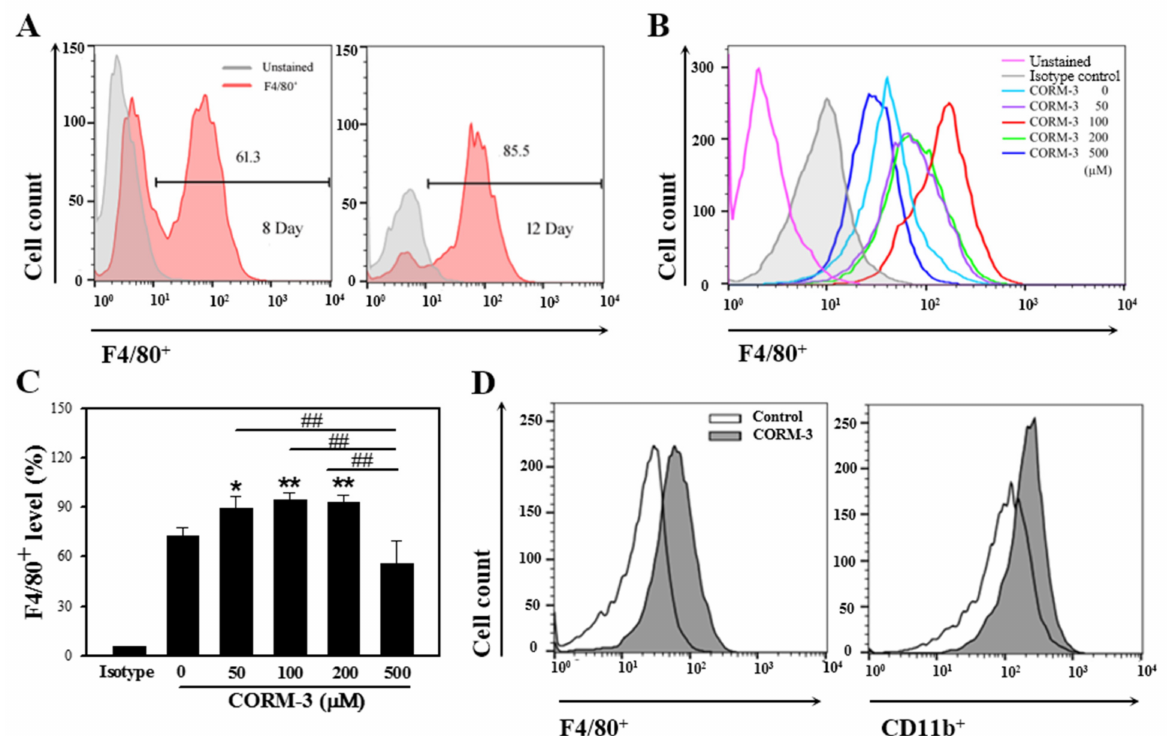
Figure 1. CORM-3 enhances macrophage differentiation. Murine BMCs were differentiated with 30 ng/mL M-CSF for 8–12 days to induce macrophage differentiation and cells were acquired on FACSCalibur. ( A ) Representative flow cytometry of F4/80-positive cells on days 8 and 12 (n = 3). ( B , C ) BMCs were treated with 0–500 µ M CORM-3 in the presence of 30 ng/mL M-CSF on day 5 and incubated for 5 days. F4/80-positive cells were analyzed on FACSCalibur (n = 3). Results were presented as mean ± SD, * p < 0.05, and ** p < 0.01 compared to 0 µ M CORM-3, and ## p < 0.01 between groups compared (one-way ANOVA). ( D ) BMCs were treated with 100 µ M CORM-3, and F4/80-positive and CD11b-positive cells were analyzed on FACSCalibur (n =